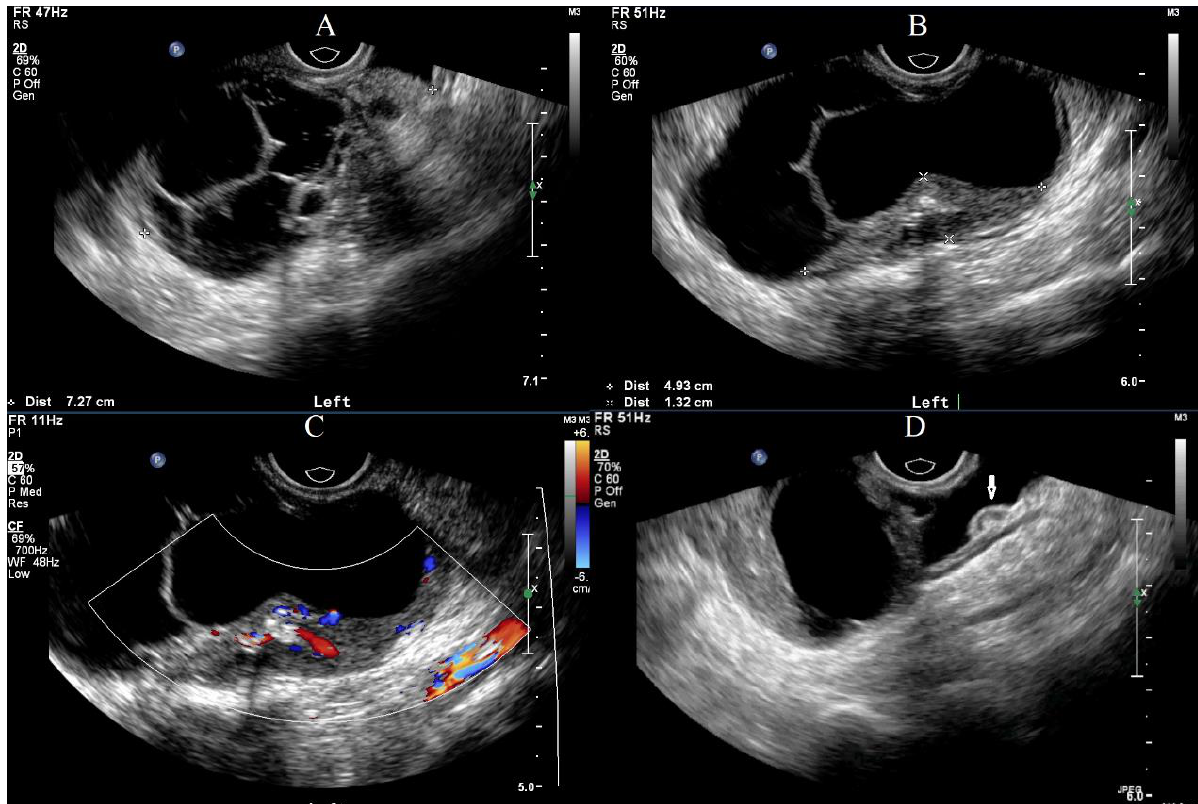
Figure 2. Ultrasonic features of the mass. ( A ) A multilocular solid-cystic mass with a clear boundary was seen in the left adnexal area, in which lipid and hair-like hyper-echo mass was also observed. ( B ) Calcification can be seen in solid hypo-echo of the mass. ( C ) The CDFI revealed scattered, short strips of blood flow signals in the solid proportion of this mass. ( D ) Implant nodules can be seen on the intestinal surface.